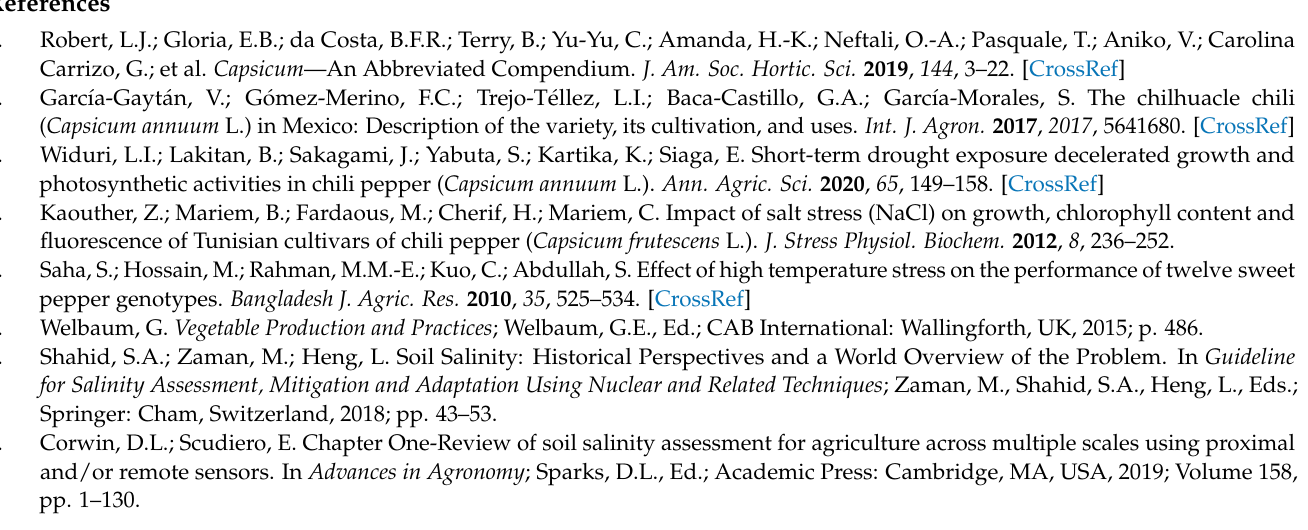
Table S5: Individual and total capsaicinoids contents of three fruit parts of the four cultivars under salt stress (mg 100 g − 1 DW; mean ±